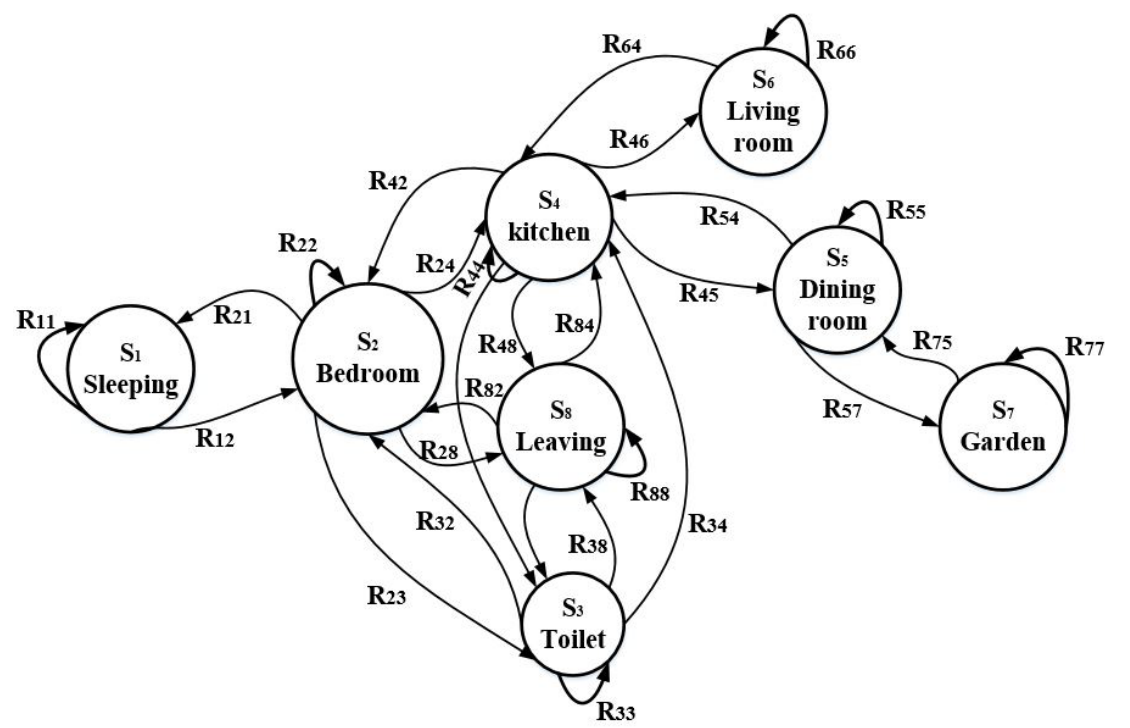
Figure 5. State diagram of human activities in the experimental